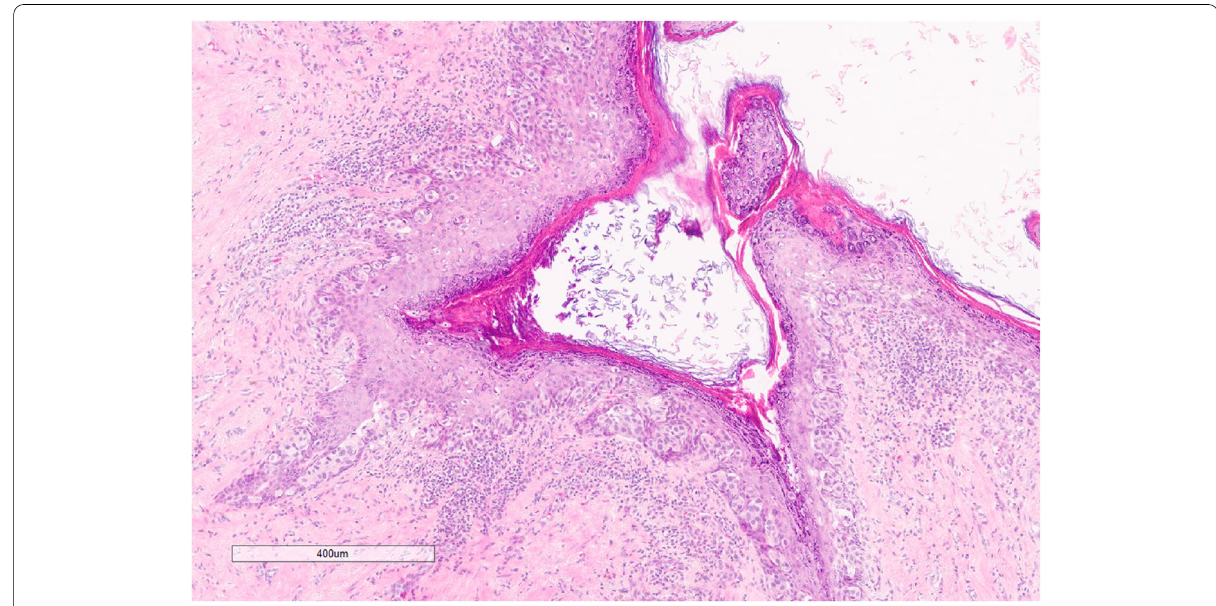
Fig. 1 Detail of Paget’s cluster pools in the epidermis and dermo-epidermal junction. HE.